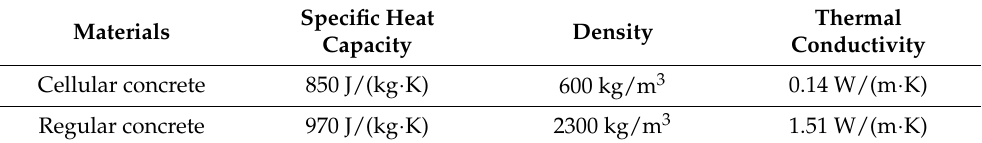
Table 3. Material properties of cellular concrete.